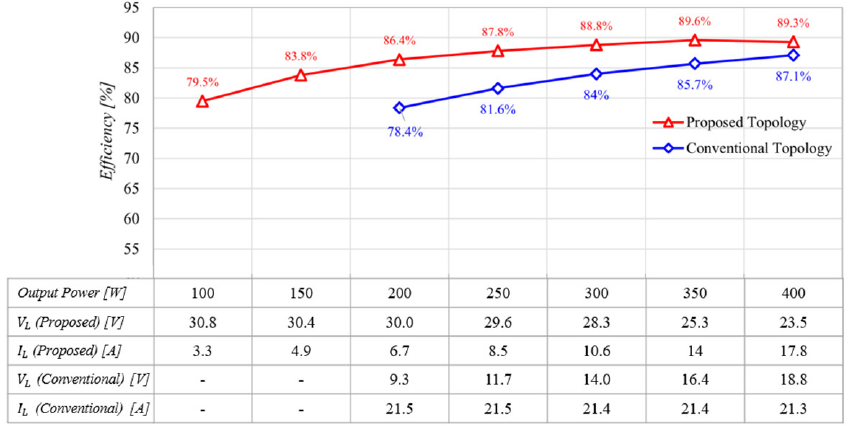
Figure 12. Efficiency of the SS topology with conventional design and proposed design under different loads.